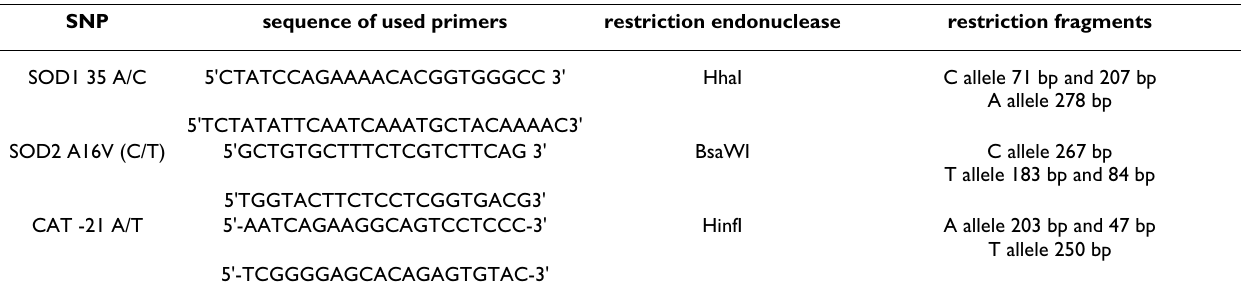
Table 2: Sequences of used primers and used restrictases.